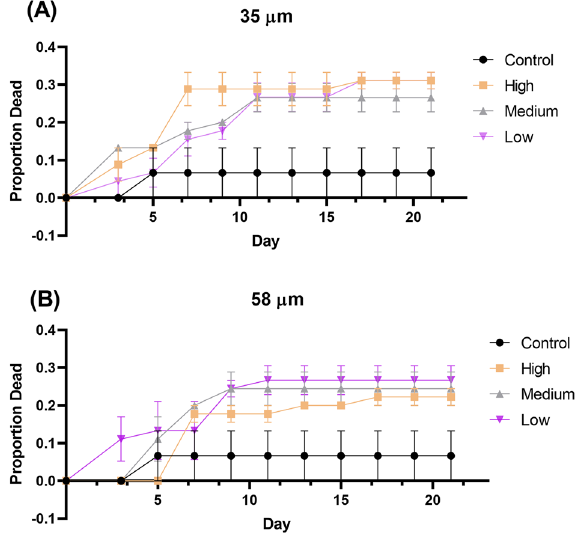
Figure 2. Toxicity curve graph showing the proportion of shrimp that died over the 23-day exposure relative to the initial concentration. ( A ) Depicts the proportion from the 35 µm exposure and ( B ) depicts the proportion from the 58 µm exposure.